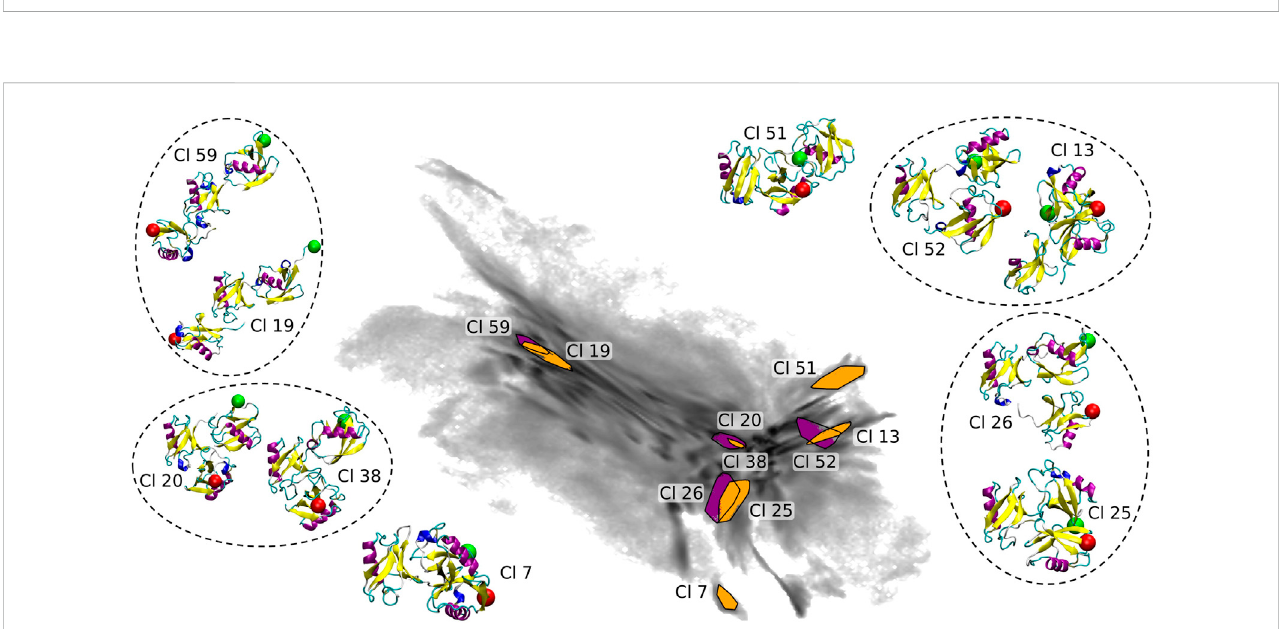
FIGURE 6 Projections of61clusters fromthecombinedBMBStrajectories(gray gradient). Bundles ofthestructures (colored according tothesecondary structure) from selected clusters are shown to visualize the homogeneity of the found clusters. The upper left inset shows the projection of the combined BMBS trajectories in the original CG landscape.